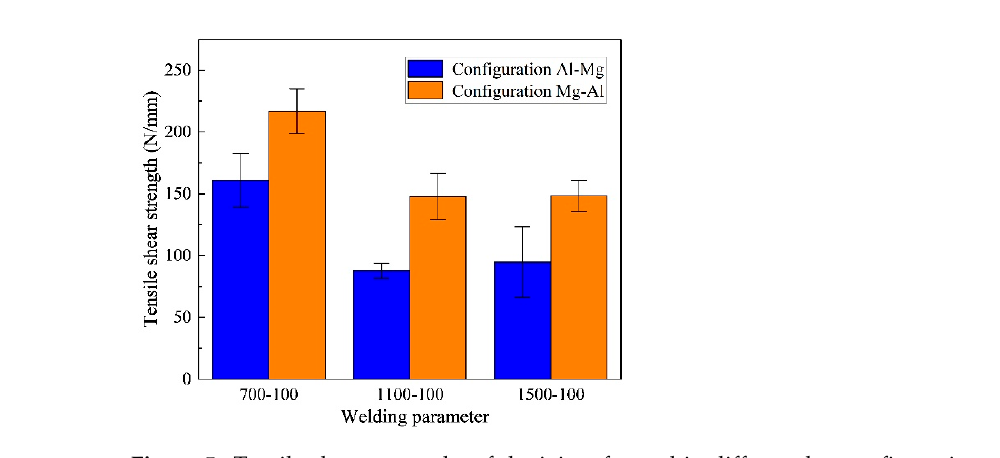
6 of 16 Figure 4. Effective lap width of joints welded in different lap configurations at different rotation speeds. 3.2. Tensile Shear Strength Figure 5 compares the tensile shear strengths of the joints with different lap configu- rations welded at different rotation speeds. For the same parameter settings, the tensile shear strength of the joint was stronger in Configuration Mg-Al than in Configuration Al- Mg. In both lap configurations, the tensile shear strength of the joint was maximized at 700 rpm (160.3 and 217 N/mm in the Al-Mg and Mg-Al configurations, respectively). The tensile shear performance of the joint welded in configuration Mg-Al was comparable to that of Ji et al. [15] after adding Zn foil (220 N/mm). As the rotation speed increased, the tensile shear strengths of both joints trended similarly to the ELW. Enlarging the ELW enhanced the tensile shear strength by increasing the crack propagation path [34]. How- ever, the strength of the joint also depends on the amount of IMCs and the microstructure characteristics in the SZ. In general, the heat input is related to the welding parameters (rotation speed and welding speed) through a parameter called the heat index ( HI ) factor [4], defined as follows: